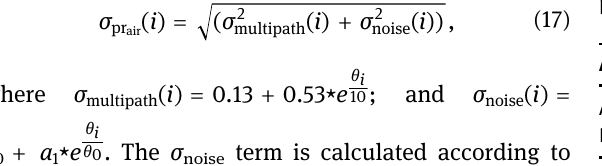
Table 1: Airbone thermal noise and interference error model for AAD